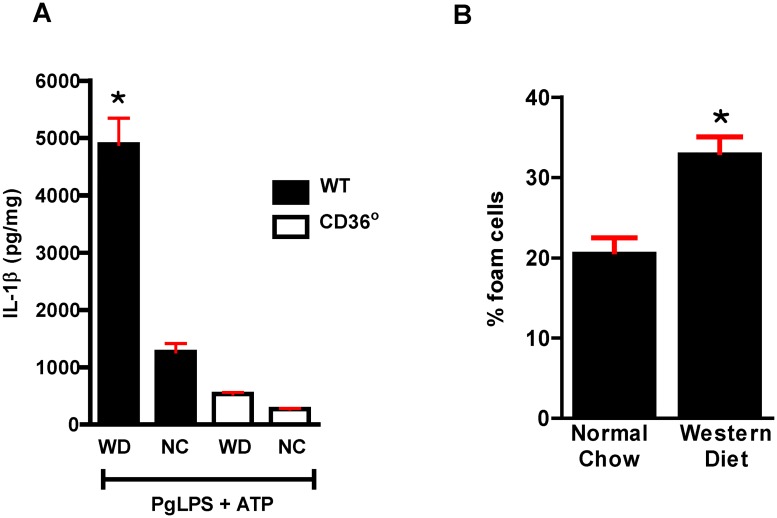
Western diet feeding influences responses to Pg.
A. Macrophages from WT Western diet fed (WD) mice generate higher levels of IL1β in response to PgLPS compared with macrophages from normal chow (NC) fed WT mice and macrophages from WD or NC fed Cd36° mice. One way ANOVA, p< 0.0001. Bonferroni’s Multiple Comparison Test, *p<0.05 vs all other groups. Experiment was performed in triplet and repeated once. B. PgLPS+oxLDL lead to greater lipid accumulation and foam cell formation in macrophages from Western diet fed Ldlr° mice compared with macrophages from normal chow fed mice. Experiment was performed in triplet and repeated once. Student’s t-test, *p<0.0001.